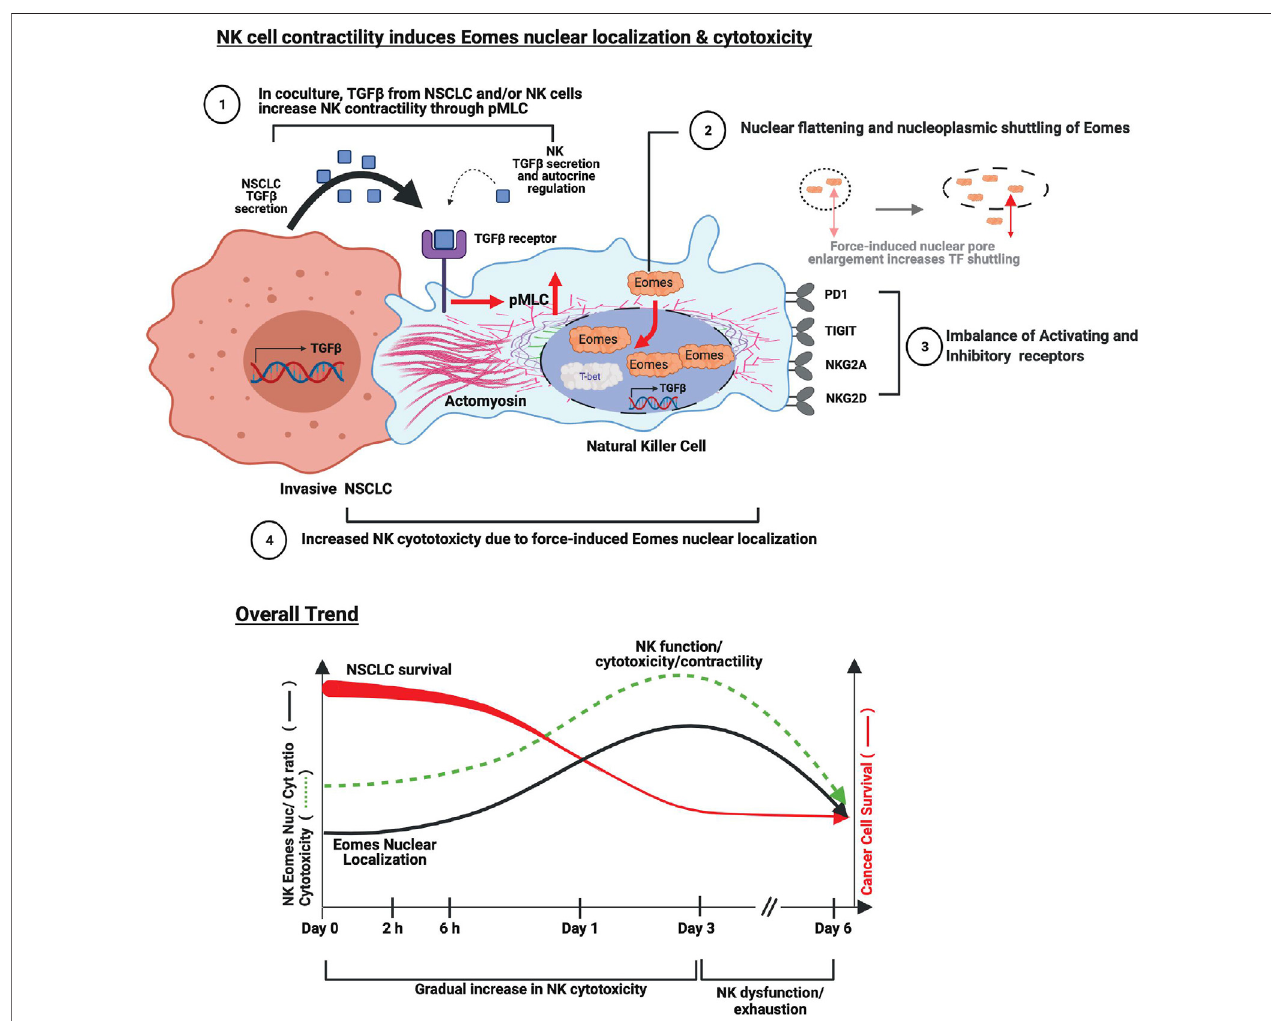
FIGURE 6 | A model summarizing NK cellular contractility which induces Eomes nuclear localization and provokes antitumor surveillance. (Cell-molecular mechanism) Metastatic invasive NSCLC (e.g., H1299) produces higher levels of TGF β to which NK cells respond by increasing TGF β R1 expression, which activates downstream signal transduction events. (1) Continuous production and secretion of TGF β persistently increases NK cell contractility through TGF β R1 upregulation and MLCphosphorylation(pMLC).ThesourceofTGF β